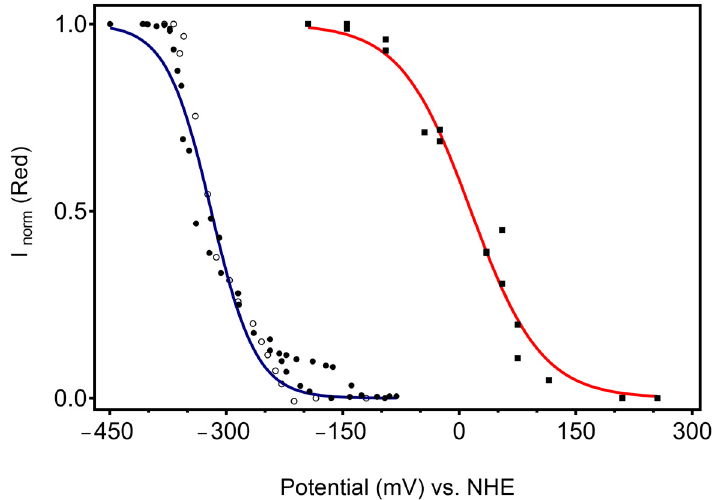
Figure 5. Redox titrations of CboDyP in solution and immobilised states. Left curve: potentiometric titration in solution monitored by UV–VIS spectroscopy. The circles represent the normalized absorption of the reduced population at 430 nm as a function of the solution potential for three independent experiments. Solid (and empty) symbols represent titrations by stepwise reduction (and oxidation) of the ferric (and ferrous) enzyme. Right curve: SERR spectroelectrochemical titration of CboDyP immobilised on electrodes coated with 1-undecanethiol and 11-amino-1-undecanethiol hydrochloride SAM (M:M, 2:1). The squares represent the relative contribution of the ferrous 6cHS population estimated from the ν 4 band (1359 cm − 1 ) at variable electrode potentials for seven independent experiments. Solid lines represent fits of the Nernst equation to the experimental data points, yielding for solution enzyme, E 0 sol = − 320 mV, n = 0.9, R 2 = 0.9698 (blue), and for immobilised enzyme, E 0 imm = +15 mV, n = 0.6 and R 2 = 0.9797